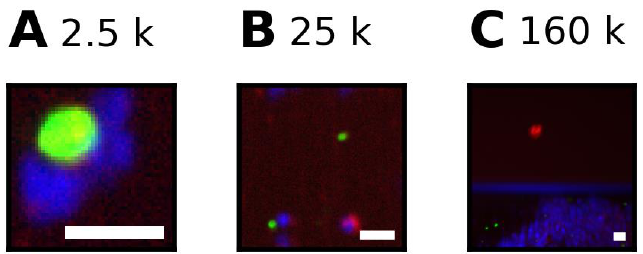
Figure 2. Examples of different segmentations sizes ( A ) Segmentation of 2500 pixels, ( B ) segmenta- tion of 25,000 pixels, and ( C ) segmentation of 160,000 pixels.